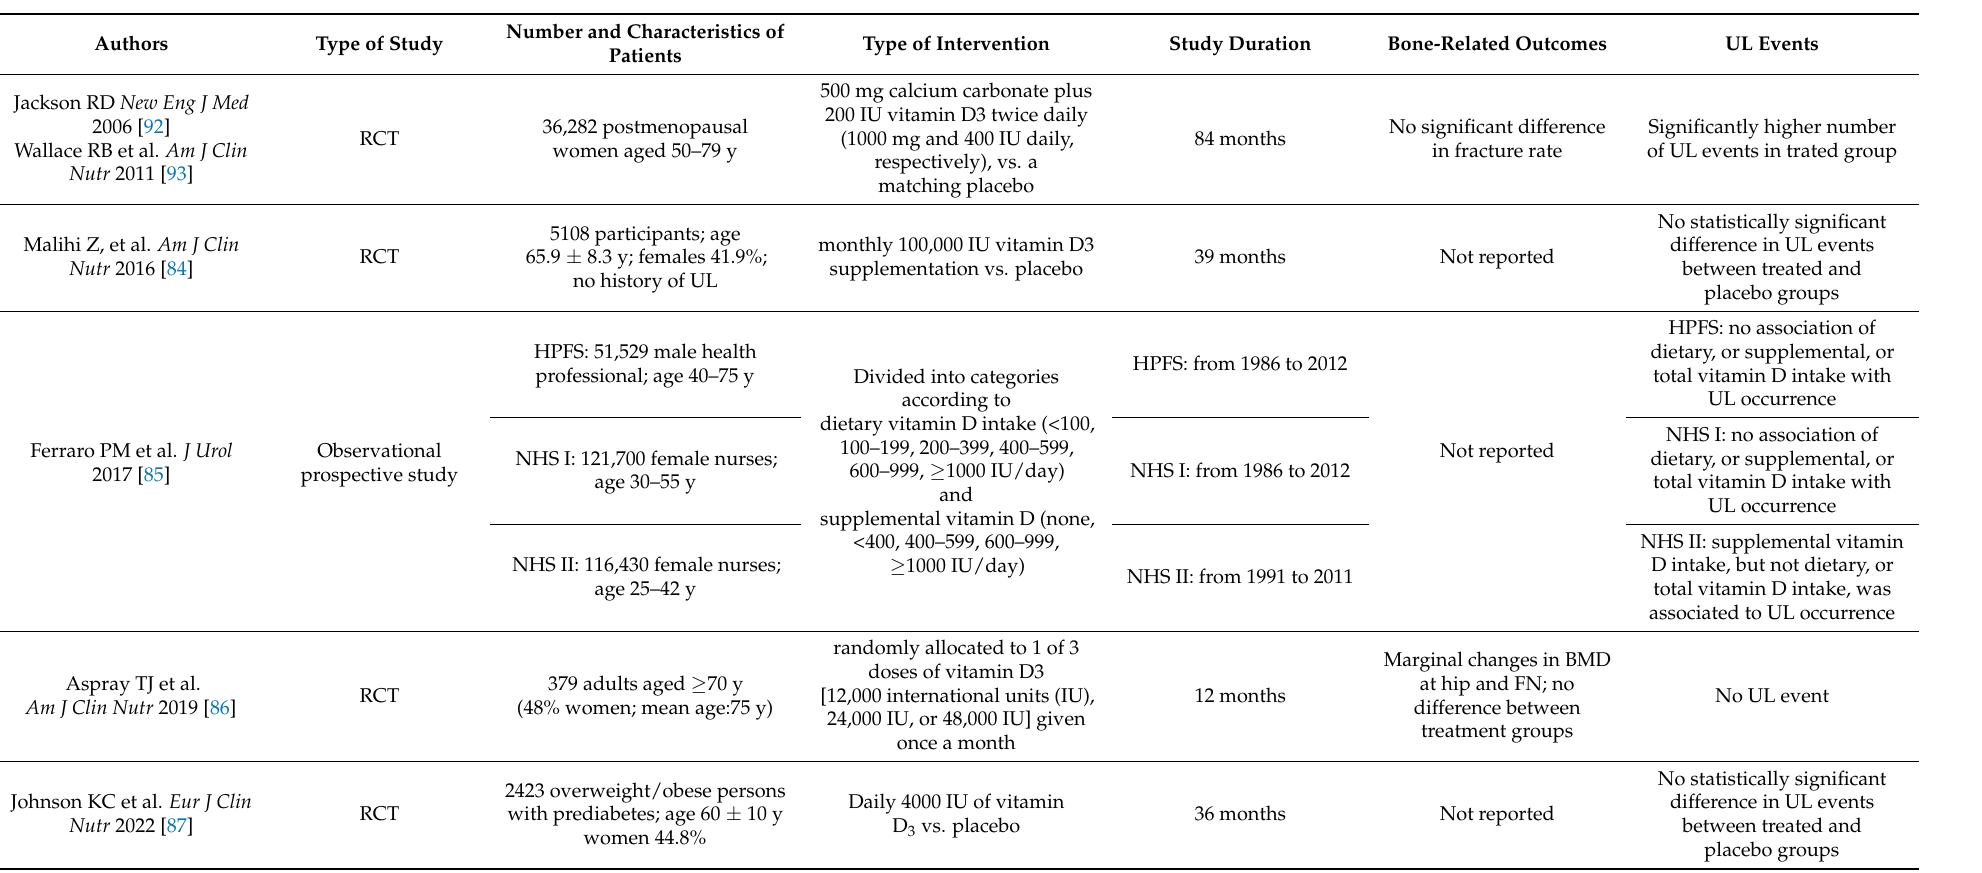
Table 1. Characteristics and results of the main studies reporting on the effects of vitamin D, with or without calcium supplementation, on UL